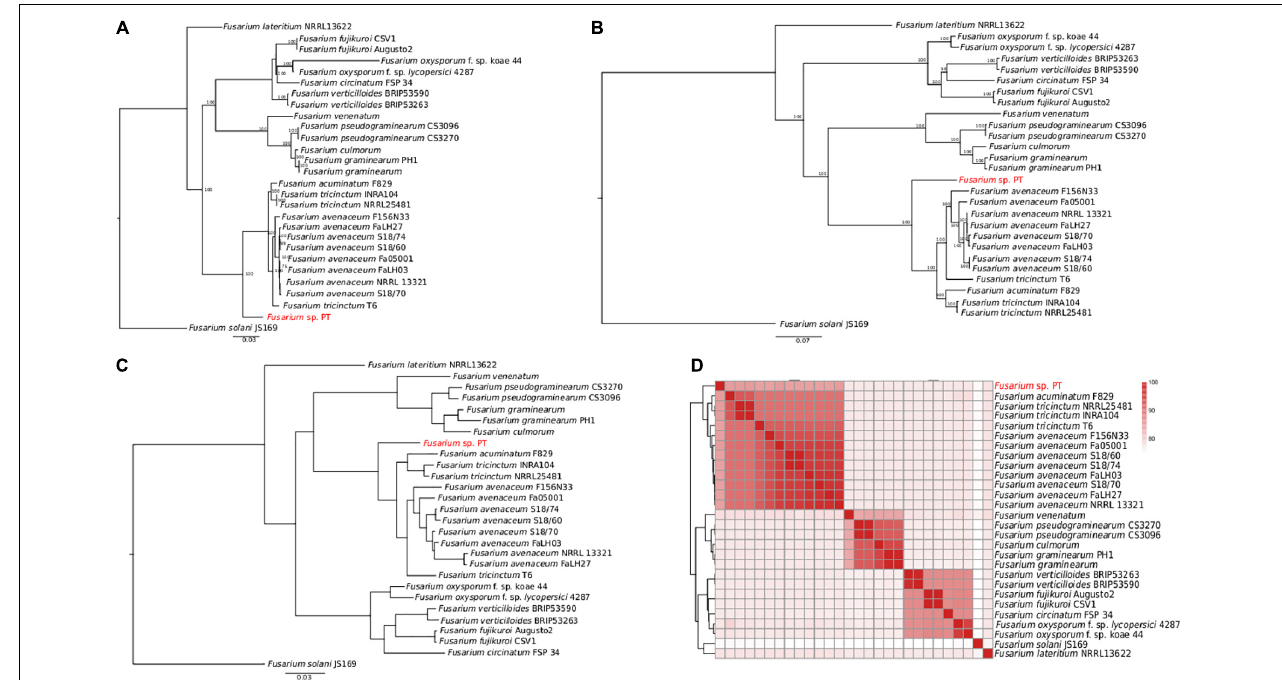
FIGURE 3 | Phylogenetic analysis of 28 Fusarium strains. (A) The ML phylogenetic tree based on the alignment of the EF-1 α , RPB1, RPB2, beta tubulin, ITS, and LSU concatenated nucleotide sequences. Only the bootstraps value higher than 70 are shown. (B) The ML phylogenetic tree based on the 4,319 core genome SNPs identified using Panseq. The number of bootstraps is indicated as well. (C) The ML phylogenetic tree of the orthologous proteins identified using OrthoFinder. In panels (A–C) Fusarium solani JS169 was used as outgroup. (D) Heatmap of the average nucleotide identity (ANI) performed using blastn showing the percentage of identify among the different Fusarium